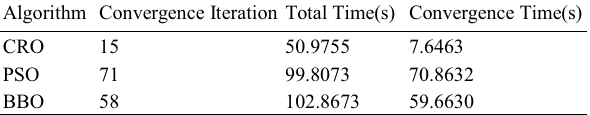
Table 2. Performances of CRO, PSO and BBO in visual